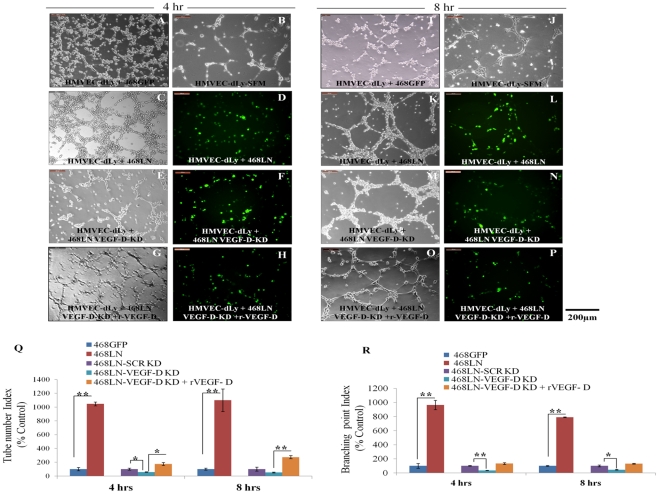
VEGF-D production by 468LN cells increased capillary-like tube formation of HMVEC-dLy cells:468GFP cells when co-cultured with HMVEC-dLy cells formed sparse and incomplete tube like structure at either 4 h (A) or 8 h (T), which were not different from HMVEC-dLy cells alone at both 4 h (B) and 8h (J) when seeded on growth factor reduced Matrigel in serum free medium (SFM). When 468LN cells were co-cultured with HMVEC-dLy cells, they showed enhanced formation of complete tubes as early as 4 h (C) and 8 h (K). (D, L) 468LN cells express GFP, so that it was evident from the images of tubes in co-culture, that both cancer cells and HMVEC-dLy cells aligned together in forming tubes, indicating cell-cell interaction or collaboration in aligned tube formation. (E, M) To test whether 468LN cell-derived VEGF-D contributed to tube formation by HMVEC-dLy cells, the same experiments were done after silencing the endogenous VEGF-D of 468LN cells. In this case, tube formation in co-cultured cells were reduced but not completely abolished. (G, O) Cells regained their tube forming capacity, when rVEGF-D (2.5 ng/ml) was added to the medium. (F, H, N, P) Again the GFP marker in 468LN cells confirms that these tubes were not exclusive to HMVEC-dLy. Quantitative data presented as (Q) tube number and (R) branching point indices. Data represent (n = 3) ± SEM. *,P<0.05; **,P<0.01.